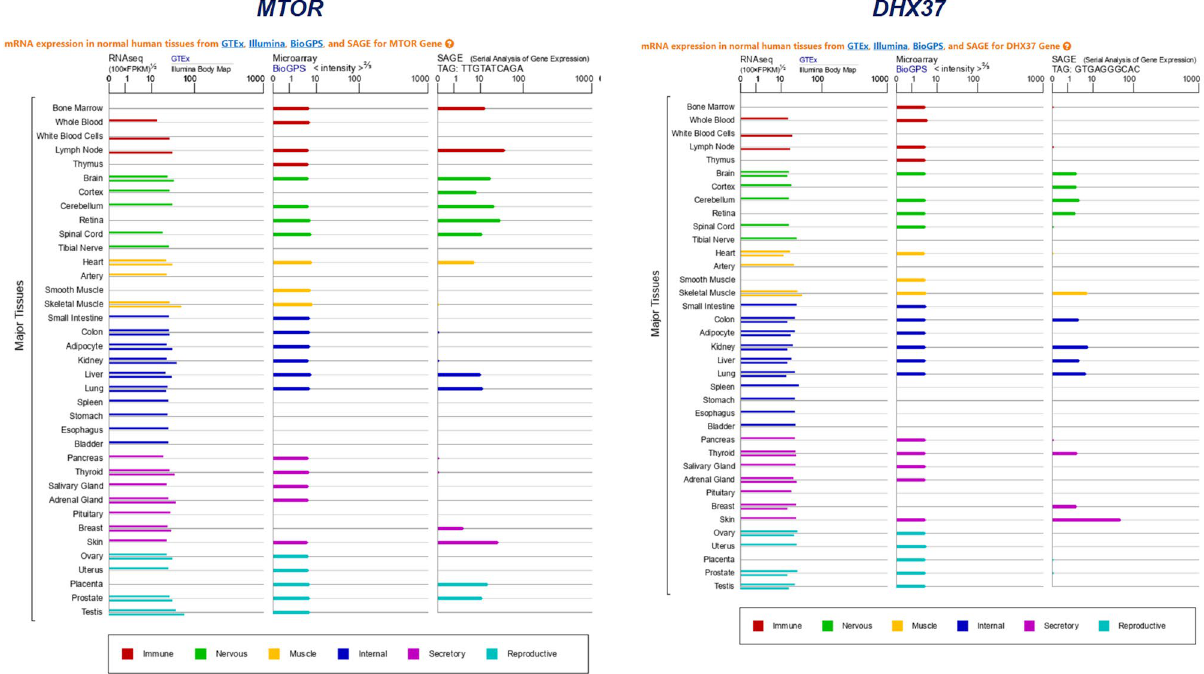
Figure 3. The mRNA expression in normal human tissues from GTEx, Illumina, BioGPS, and SAGE for MTOR and DHX37 genes. The results showed high transcript levels of both genes in immune system, skin and skeletal